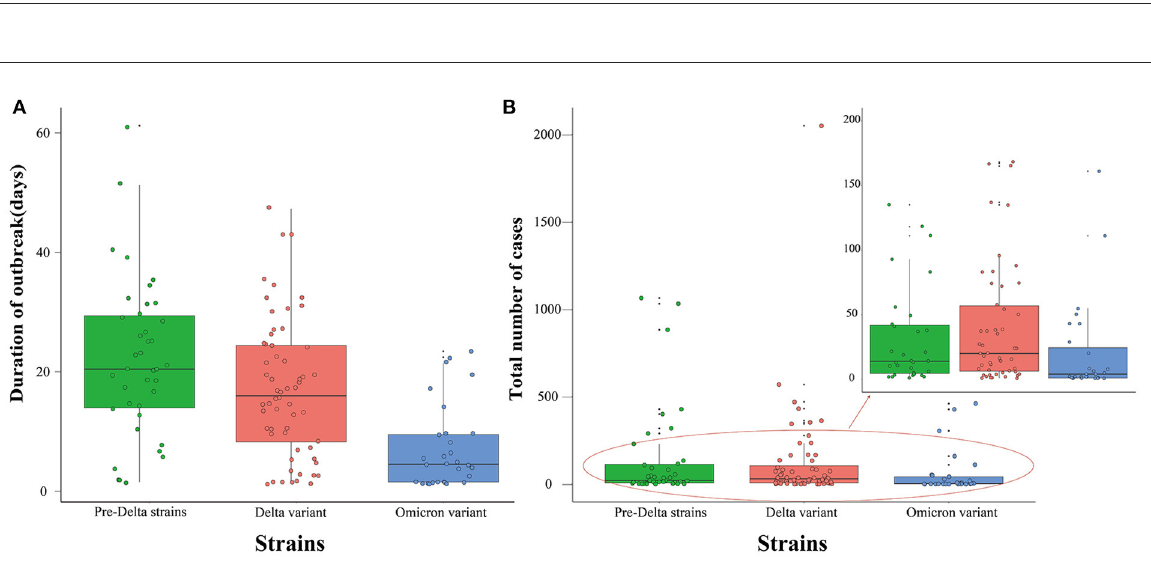
FIGURE5 Duration of outbreak and total number of cases of all pre-Delta strains, Delta variant and Omicron variant outbreaks in China from March 28, 2020 to March 1, 2022. (A) Duration of outbreak. (B) Total number of